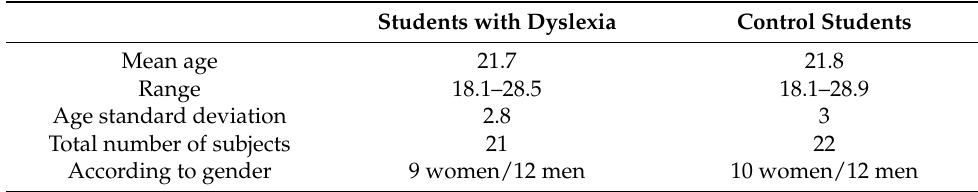
Table 1. Description of participants in the psycholinguistic task.